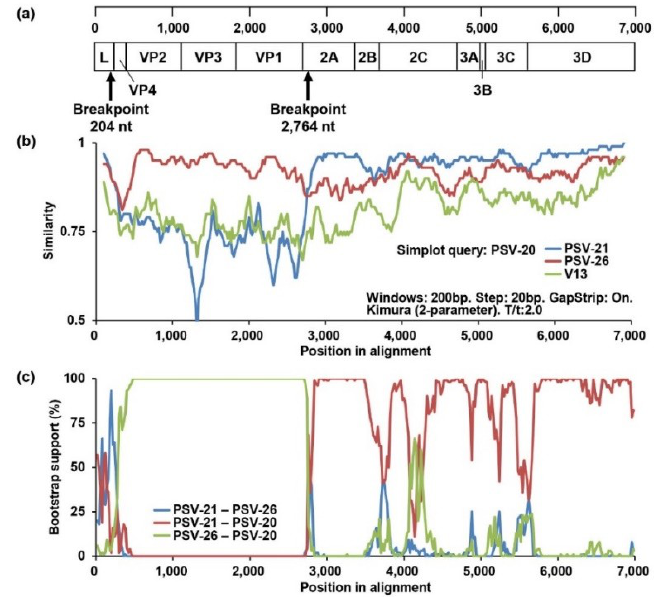
Figure 3. Identification of the recombination events among Zambian PSVs. ( a ) Predicted recombination breakpoints are shown with black arrows on the schematic diagram of the PSV genome. ( b ) Similarity analyses of complete ORF nucleotide sequences of PSV-20, PSV-21, PSV26, and V13 strains were performed using SimPlot software version 3.5.1 with the default setting. The genome of PSV-20 was used as a query sequence. The similarities plots of PSV-21 (blue line), PSV-26 (red line), and V13 (green line) are shown. ( c ) Recombination breakpoint analyses were conducted using RDP version 4.97 with the sequences of all Zambian PSVs. The recombination among PSV-20, PSV-21, and PSV-26 predicted by the analyses using the Bootscan method is shown. The bootstrap support values of PSV-21 versus PSV-26 (blue line), PSV-21 versus PSV-20 (red line), and PSV-26 versus PSV-20 (green line) are